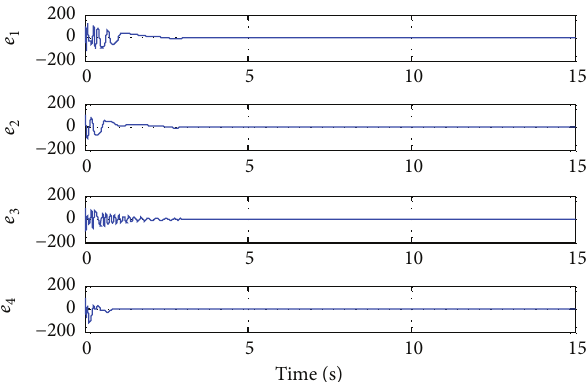
Figure 9: Time histories of error states for Case III.